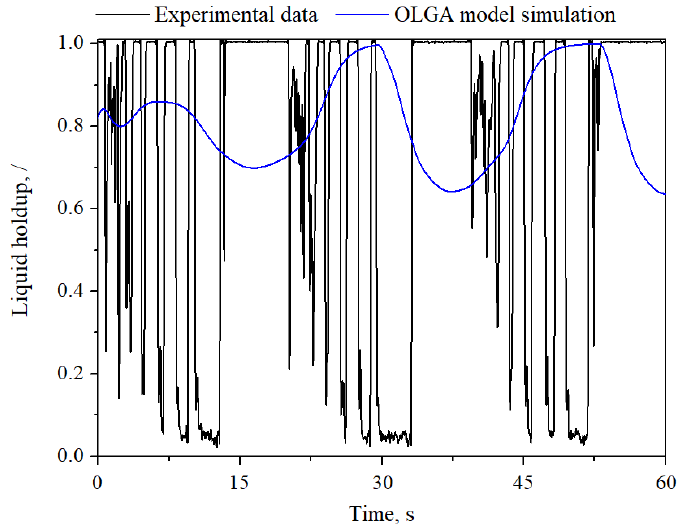
Figure 20. Experimental and simulated profile of liquid holdup in choking-induced slug flow ( U GS = 0.08 m/s and U LS = 0.09 m/s).